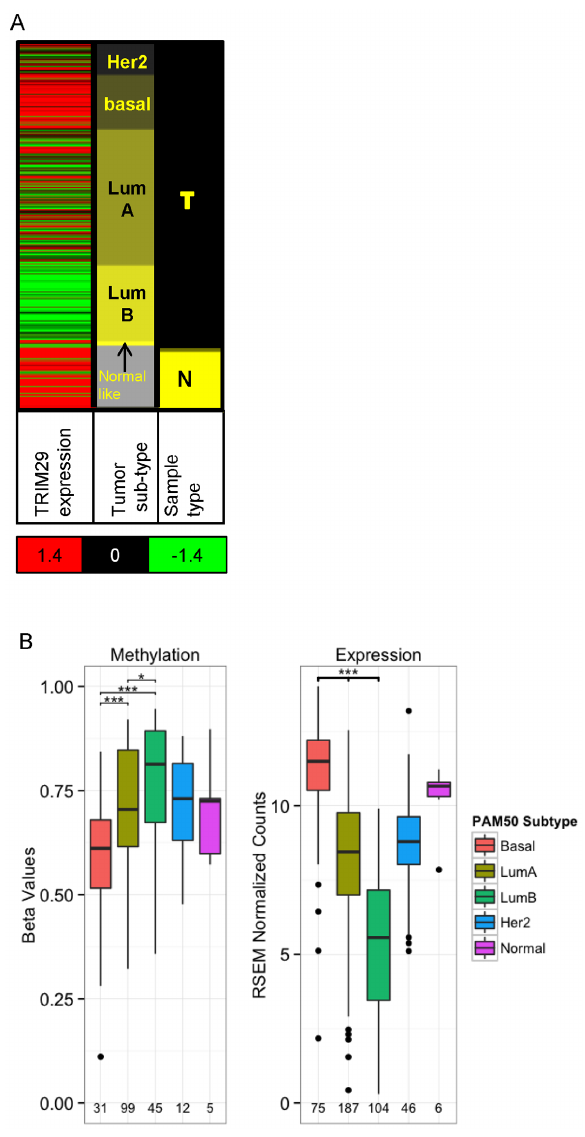
Figure 5. TRIM29 gene expression and promoter methylation varies in breast cancer subtypes. Analysis of TCGA data base shows ( A ) variable gene expression of TRIM29 in normal breast tissues (n=97) and in breast tumor subtypes defined by the PAM50 classification: basal (n=75), luminal A (n=187), luminal B (n=104), HER2 (n=46), normal- like (n=6). Heat map scale ranges from red (high) to green (low). ( B ) Variable methylation at the promoter of TRIM29 (Illumina probe # cg13625403) in breast tumor subtypes. Expression inversely correlates with promoter methylation. Data was selected from TCGA data base as described in methods. Number of samples indicated at the bottom, *** p , 0.001, * p , 0.01, P-values between groups were calculated using Welch’s corrected